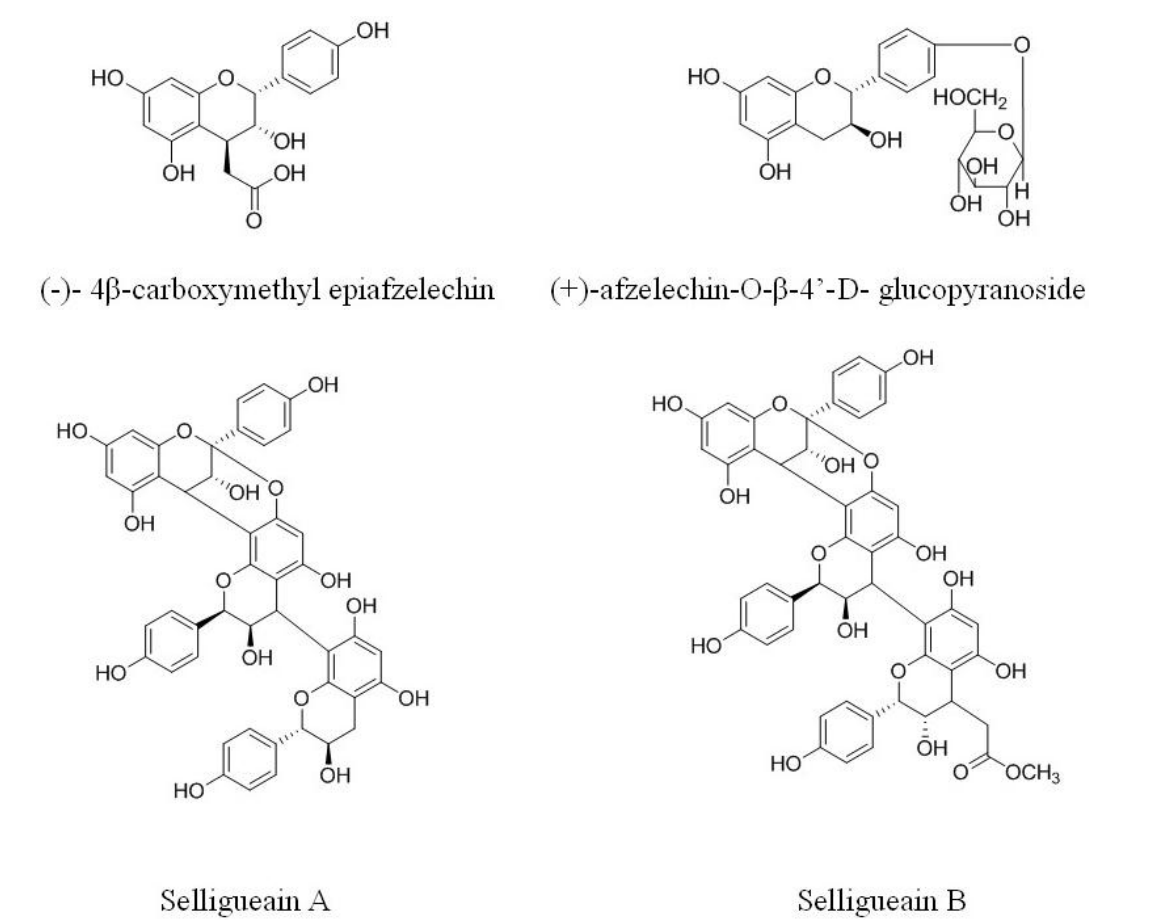
Figure 1. Flavanol monomers and proanthocyanidins reported in Selliguea feei